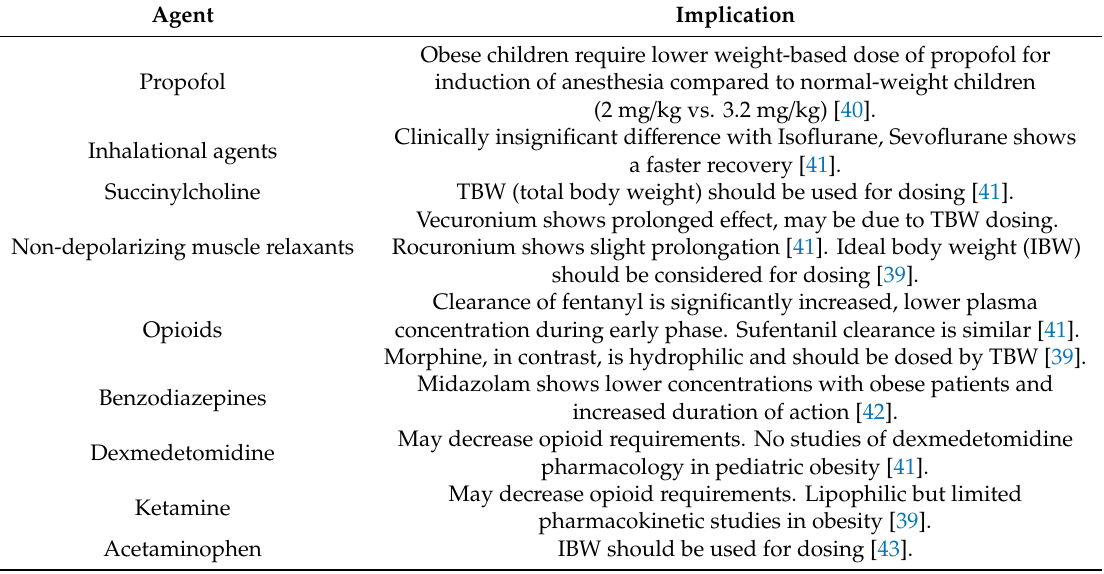
Table 1. Considerations for anesthetic agents in pediatric patients with